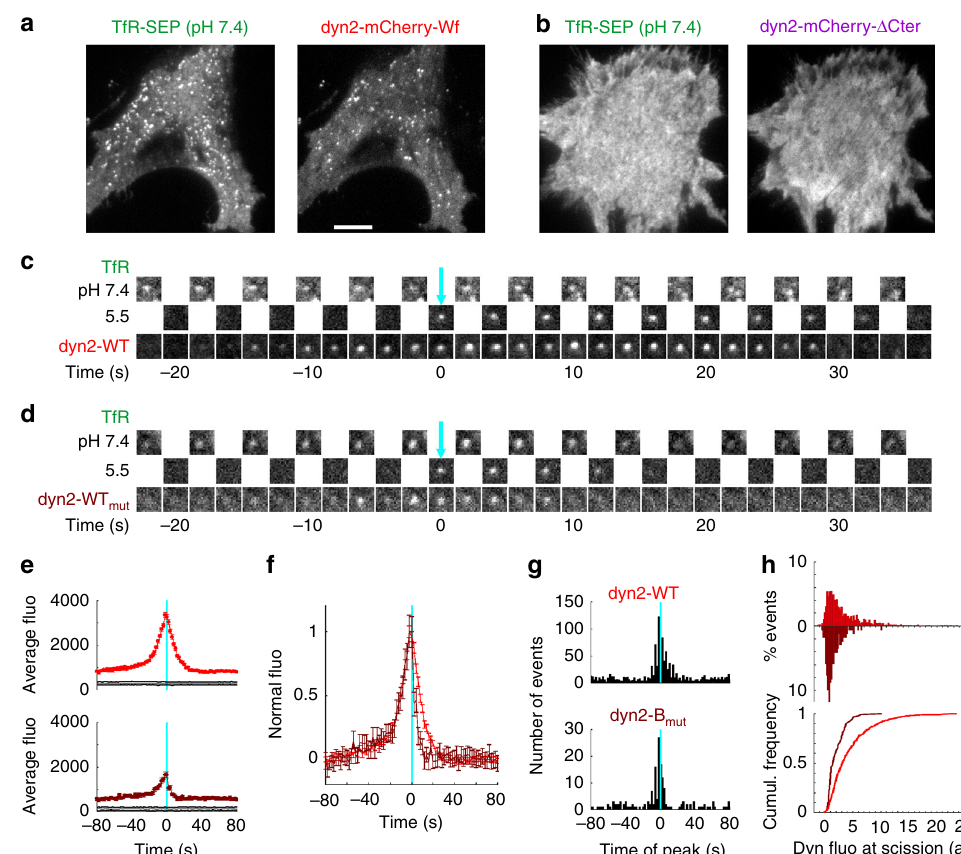
Fig. 3 Kinetics of dynamin recruitment to forming CCVs measure with ppH. a , b Images of a TKO cell co-transfected with TfR-SEP and dyn2-mCherry-WT ( a ) or dyn2-mCherry- Δ Cter ( b ). Note the punctuated pattern of both markers with dyn2-WT which becomes homogenous with dyn2 Δ Cter. Scale bar 10 µ m. c ,Example of a scission event recorded in the cell shown in A. Note the transient recruitment of dyn2-mCherry-WT which peaks around time 0. d Same as h for a TKO cell co-transfected with TfR-SEP and dyn2-mCherry-B mut . e Average fl uorescence of dyn2-mCherry of events recorded in cells co- transfected with TfR-SEP and dyn2-mCherry-WT (top, red trace, 1193 events in 5 cells) or dyn-mcherry-Bmut (bottom, brown trace, 171 events in 7 cells) and aligned to the time of scission (cyan line). The black lines indicate 95% con fi dence intervals for signi fi cant recruitment. f The curves in ( e ) are normalized to their peak. g Histograms of the timing of peak dyn2 recruitment in single events relative to scission (cyan lane). h Histograms (top) and cumulative distributions (bottom) of the amplitude of dyn2-mCherry at the time of scission for events recorded with a peak recruitment within 10 s before or after scission (580 and 97 events in cells transfected with dyn2-mCherry-WT, in red, and dyn2-mCherry-B mut , in brown, histogram reversed,